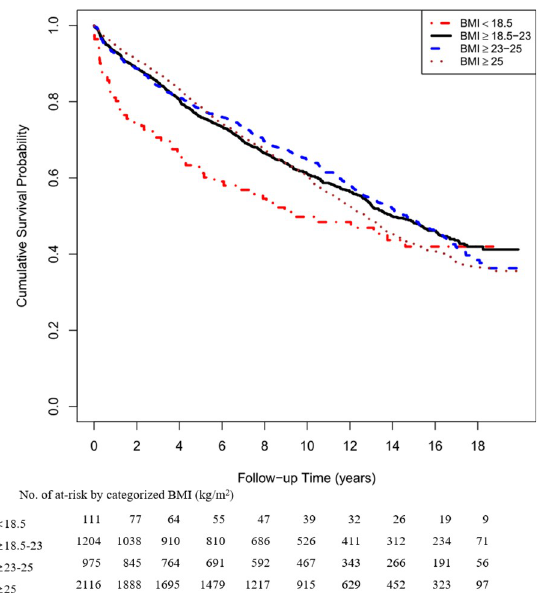
Fig 2. Survival curves for 4 BMI categories according to the World Health Organization definition for obesity in Asians. BMI, body mass index.